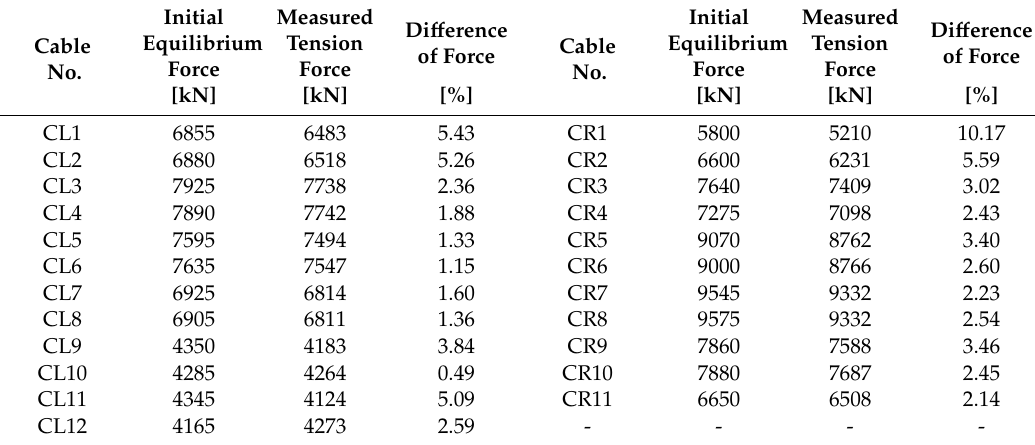
Table 8. Comparison of cable tensional force for